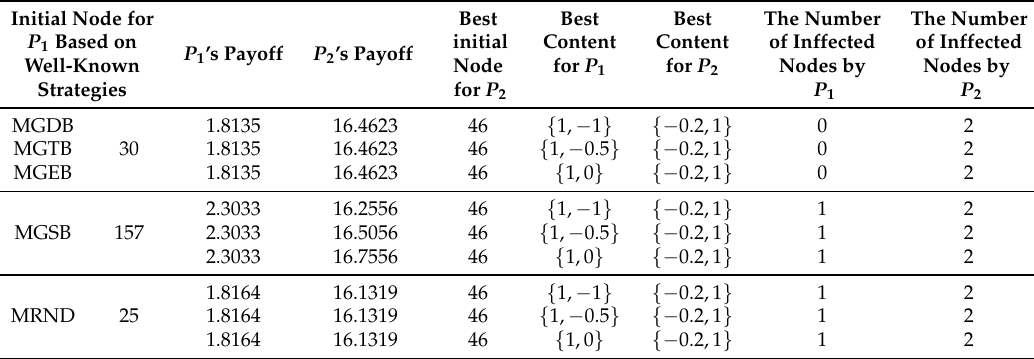
Table 4. Nash equilibrium when player 1 performs based on some well-known strategies.